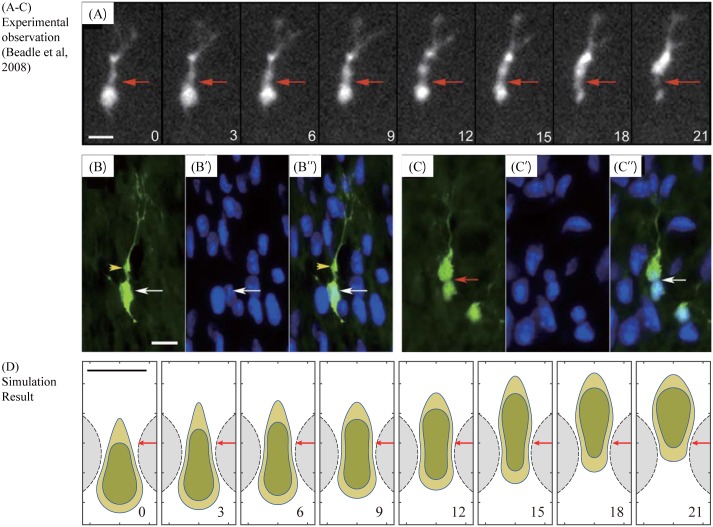
Experiments and simulation results using a mathematical model.(A-C) Experimental results of a GFP-expressing rat glioma cell. Time courses of the profiles of a moving glioma cell in (A) show the deformation of the cell body during cell translocation. Micrographs taken at 3-min intervals (t = 0, 3, 6, 9, 12, 15, 18, 21 min). Red arrowhead = a focal point between the cell body and the swelling in the leading edge. Micrographs of a section stained for GFP (green; moving glioma cell) and DAPI (blue; resident brain cells) show GFP-expressing glioma cells at distinct two phases of the migration in (B,C). While the nucleus (white arrow) is separated from a prominent dilatation at the front (yellow arrowhead) in the first step (B − B′′), a focal deformation of the nucleus (red arrow) and cell body is observed in the next step (C − C′′). Bars, 10μm. Reprinted from Beadle C, Assanah M, Monzo P, Vallee R, Rosenfield S, et al. (2008) The role of myosin II in glioma invasion of the brain. Mol Biol Cell 19: 3357-3368 [11] under a CC BY license, with permission from American Society for Cell Biology, original copyright 2008. (D) Time courses of cell morphology as a glioma cell migrates through a narrow gap between two glial cells in the brain. Bars, 10μm. Profiles of a glioma cell with deforming nucleus (dark green) at t = 0, 3, 6, 9, 12, 15, 18, 21 min are shown in the presence of two normal cells (gray region with dotted line cell boundaries).